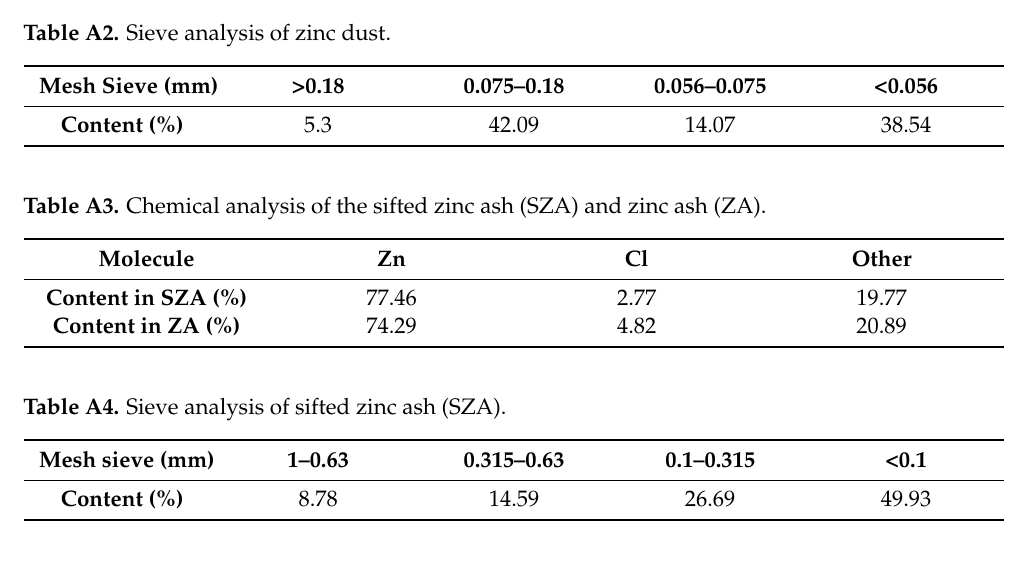
Table A5. Sieve analysis of zinc ash (ZA).